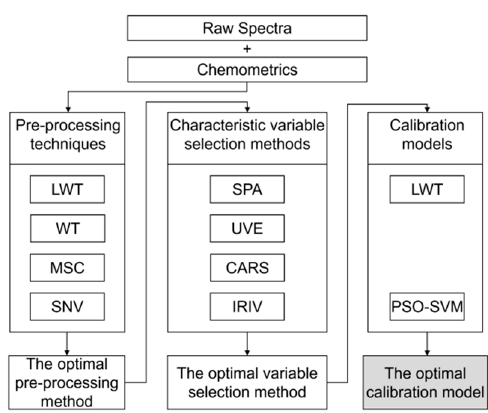
Figure 1. Steps of the optimization